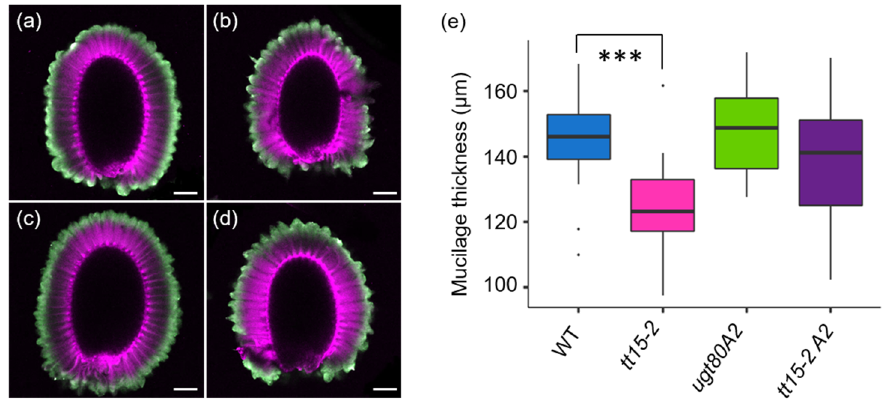
Figure 10. The width of the inner mucilage layer is reduced for tt15 single mutant seeds. ( a – d) , composite images of confocal microscopy optical sections of seeds immuno-labeled with an antibody against rhamnogalacturonan I (green) to delimit the outer edge of the inner mucilage layer and stained with Direct Red 23 (magenta) to label cellulose in the mucilage and at the seed surface. ( a ), wild type; ( b ), tt15-2 ; ( c ), ugt80A2 ; ( d ), tt15-2 ugt80A2 . Scale bars: 100 µm. ( e ), Measurements of mucilage width for each genotype. Dunnett pairwise comparison test to wild type *** p < 0.01%, n = 30. WT, wild type; tt15-2 A2 , tt15-2 ugt80A2. All genotypes are in the Ws-4 background.